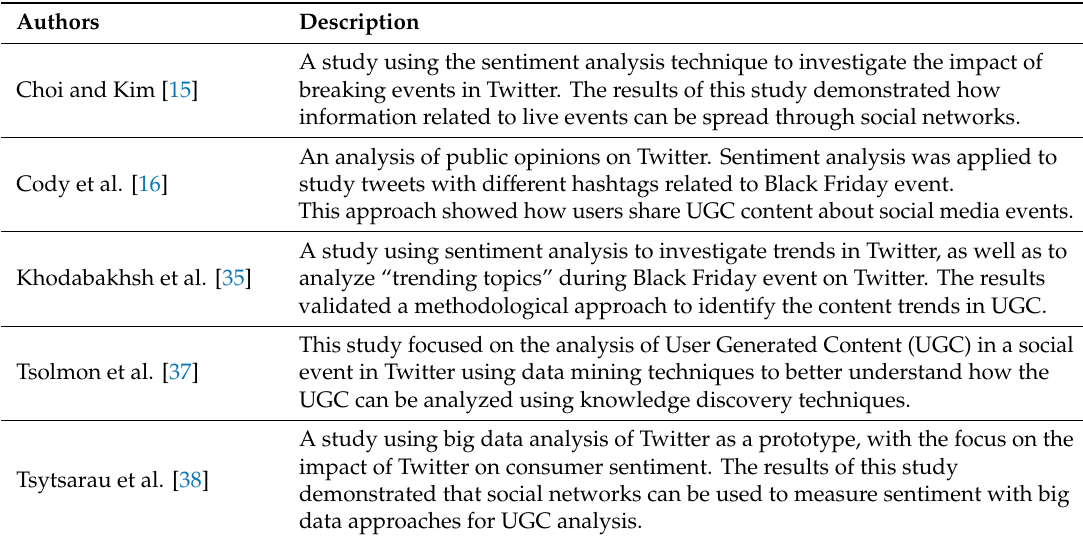
Table 1. Previous studies on Black Friday that used sentiment